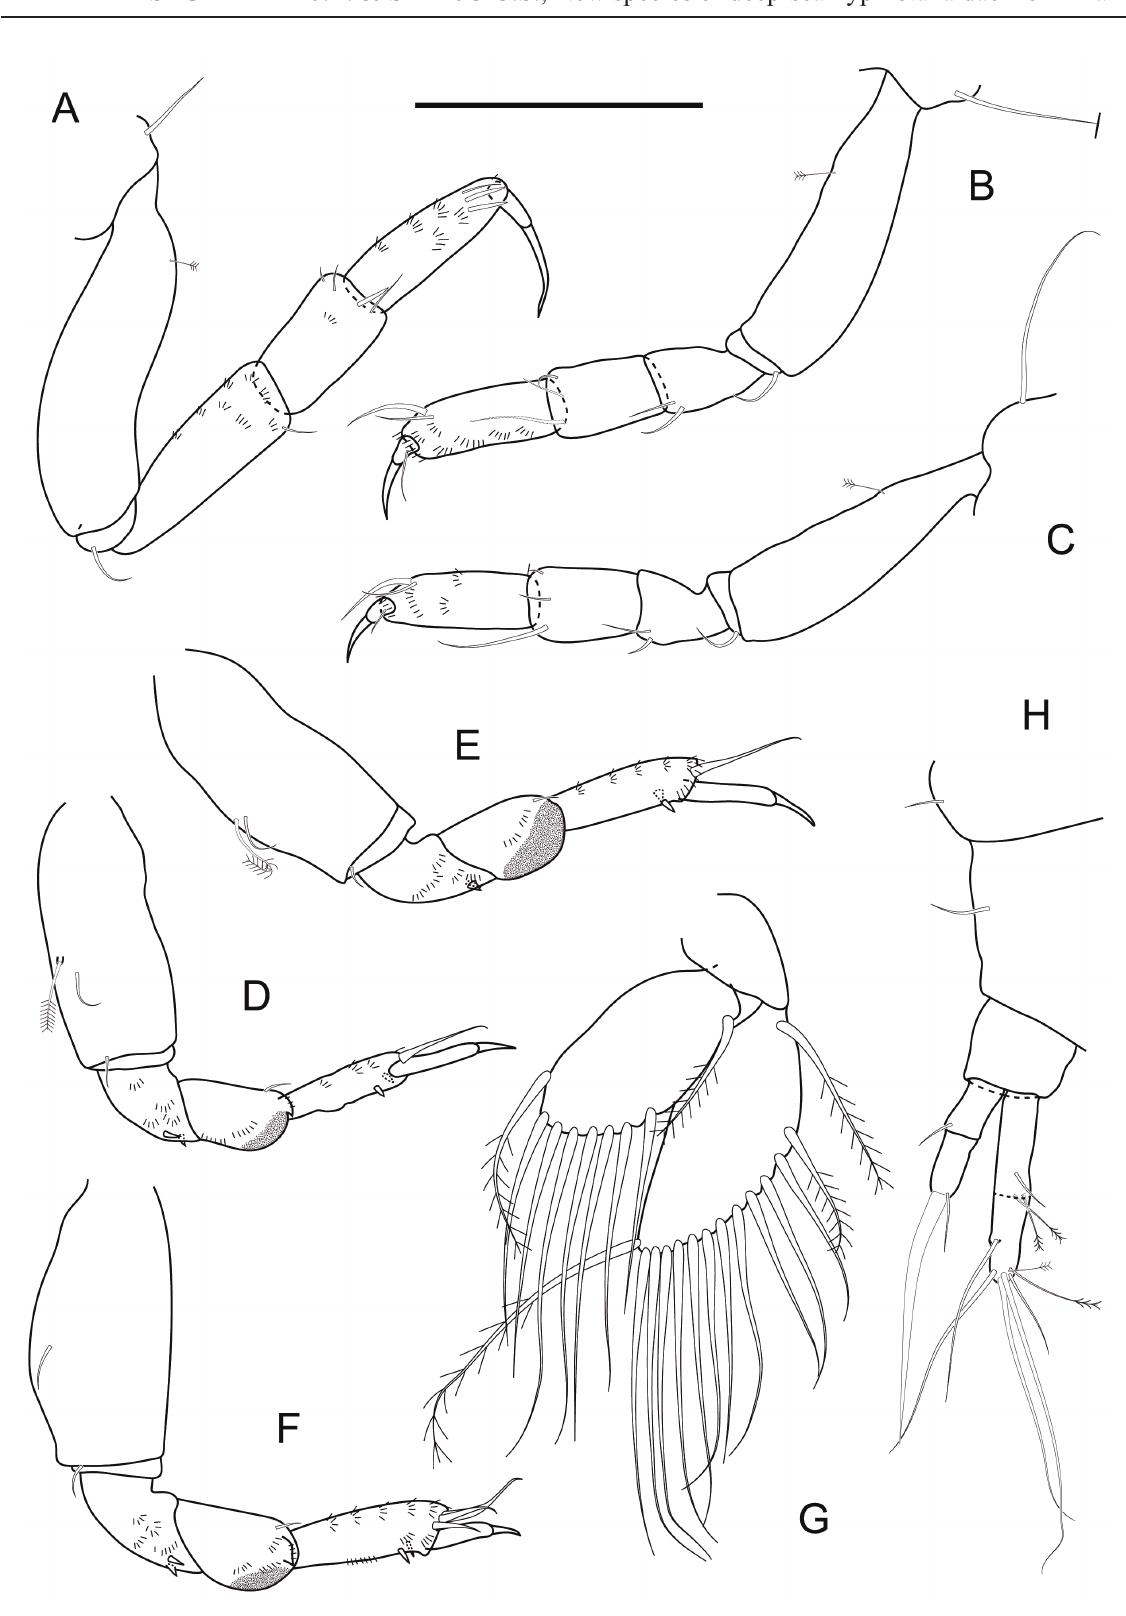
Fig. 4. Typhlotanais andradeorum sp. nov., paratype (MZUSP 32839), ♀, dissected. A–F . Pereopods 1–6. G . Pleopod. H . Uropod. Scale bar = 0.1